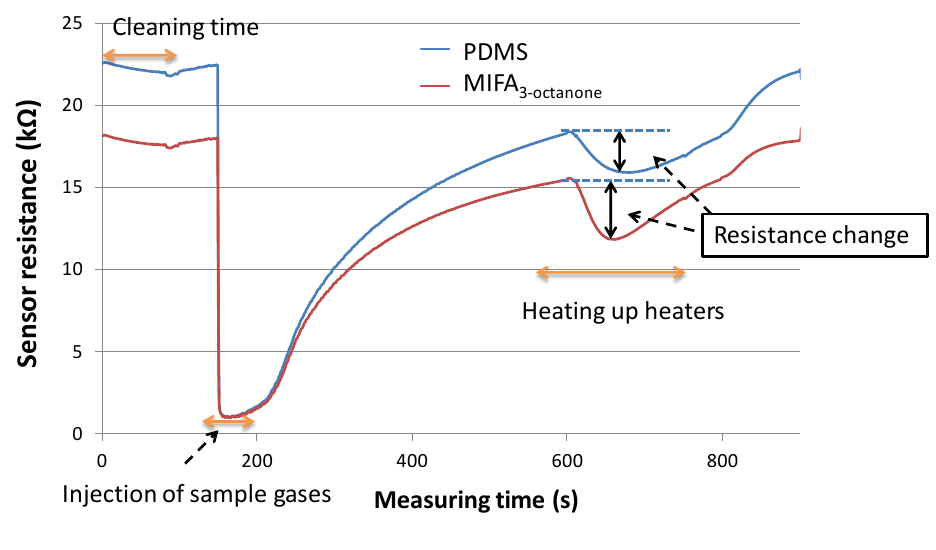
Figure 6. The responses of gas sensors consisting of untreated PDMS and MIFA when injecting 3-octanone into the